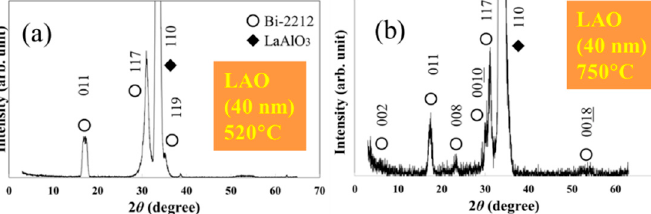
Figure 3. XRD patterns of non c-axis Bi2212 films grown on flat (110) LAO substrate at ( a ) 520 and ( b ) 750 ◦ C (orientations and thickness are also indicated).